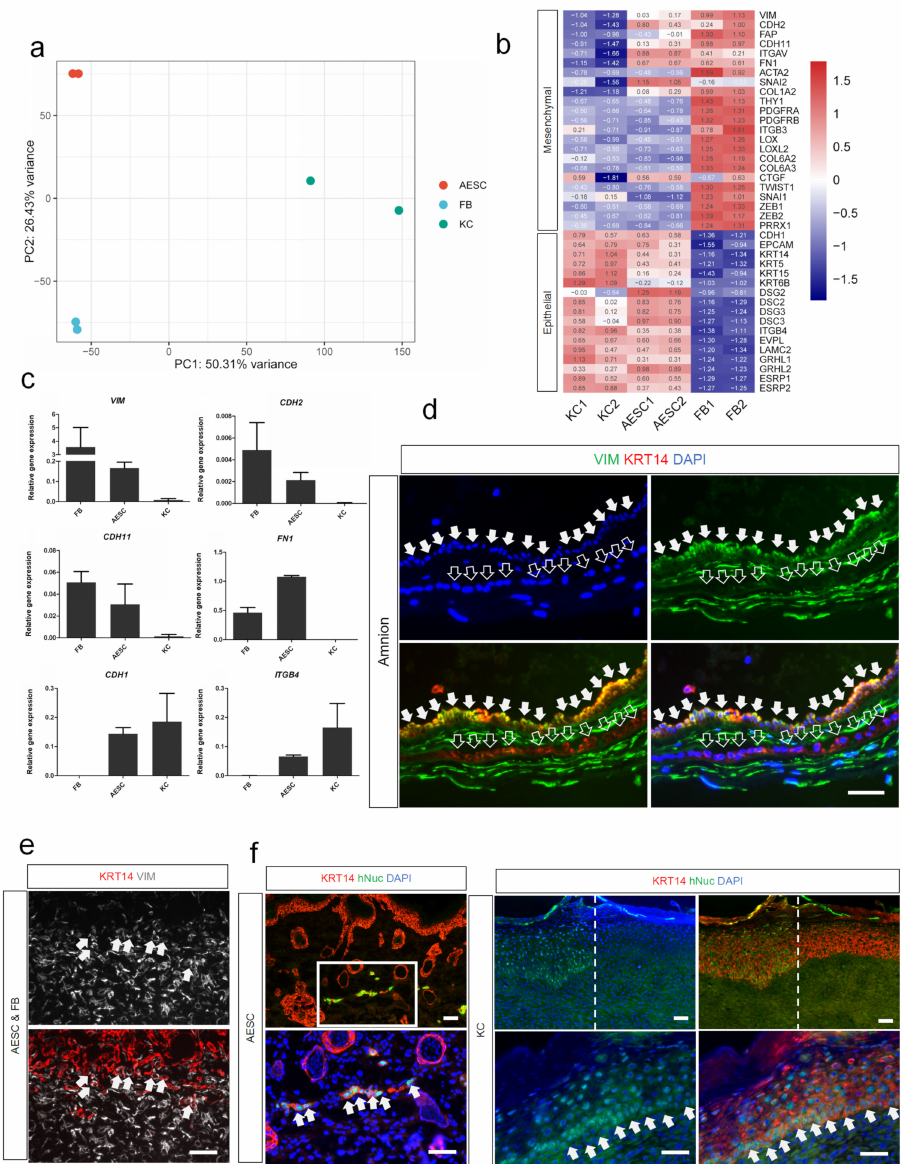
Figure 3. Difference between amniotic epithelial stem cells (AESCs) and keratinocytes (KCs) in mesenchymal characteristics. ( a ) Principal component analysis of AESCs, KCs, and FBs. ( b ) Heatmap showing that both mesenchymal genes and epithelial genes were highly expressed in AESCs. ( c ) qRT-PCR analysis of mesenchymal ( VIM , CDH2 , CDH11 , FN1 ) and epithelial ( CDH1 , ITGB4 ) genes. ( d ) VIM (green) and KRT14 (red) immunostaining in the amnion. Arrows: VIM + KRT14 + cells; Empty arrows: VIM − KRT14 + cells. ( e ) VIM (grey) and KRT14 (red) immunostaining in re- constructed 3D skin using AESCs and FBs. Arrows: VIM + KRT14 + cells. ( f ) Immunostaining for human nuclei (hNuc, green) and KRT14 (red) in reconstituted skin using AESCs and KCs, respectively. Arrows: hNuc + KRT14 + cells. FB, fibroblast; AESC, amnion epithelial stem cell; KC, keratinocyte. Bars represent relative expression normalized to GAPDH (mean ± SD) calculated from at least three independent experiments. Scale bar = 50 µ m ( d , e , f